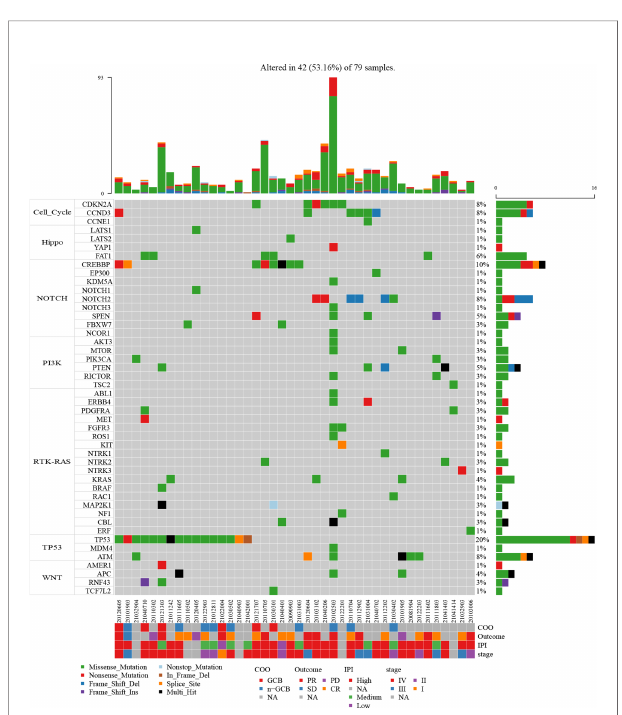
FIGURE 3 | Mutation plot of seven canonical oncogenic signaling pathways (cell cycle, Hippo, Notch, PI3-Kinase, RTK-RAS, p53, and Wnt pathways) in 79 B-cell lymphoma patients. Color-coded is indicated by type of mutation. Y axis shows the percentages of patients with at least one mutation in the speci fi ed